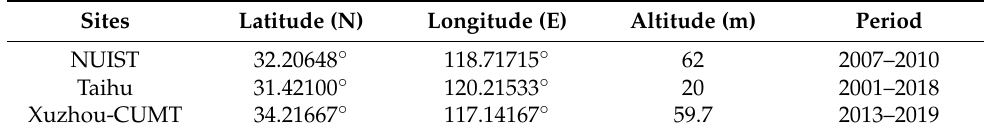
Table 1. AERONET sites information and data availability. Sites Latitude (N) Longitude (E) Altitude (m) Period NUIST 32.20648 ◦ 118.71715 ◦ Taihu